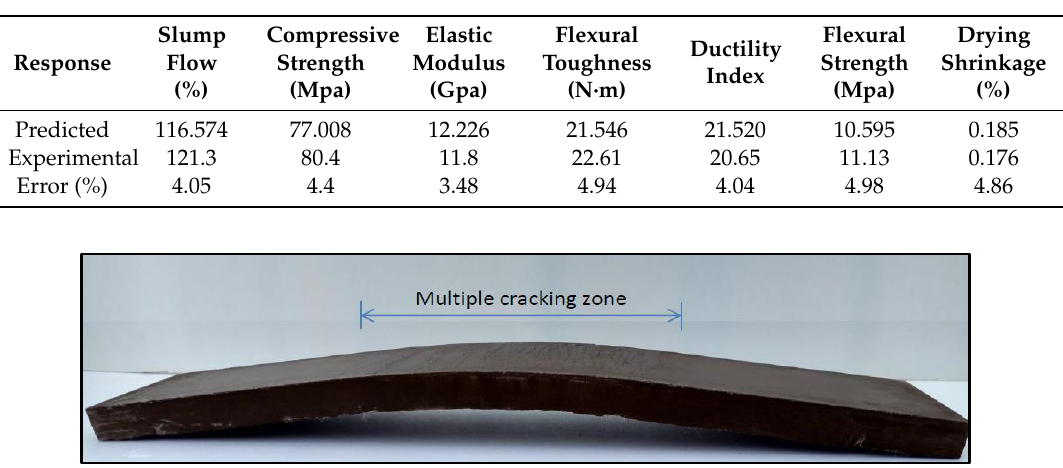
Table 12. Experimental validation of the optimized Mixture.